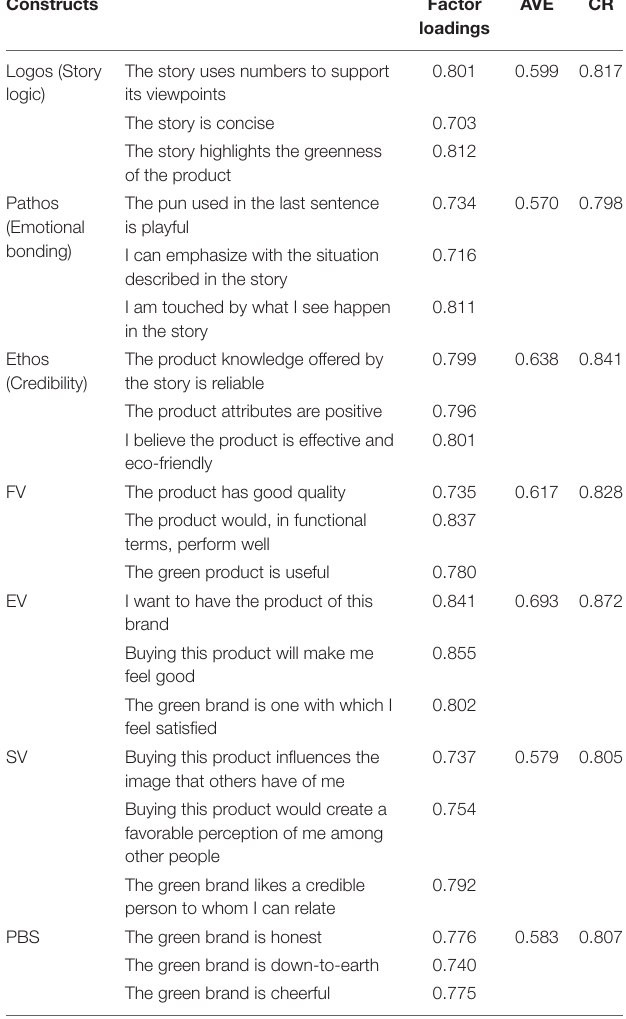
scales of Davis (1994), which foreground perspective taking and